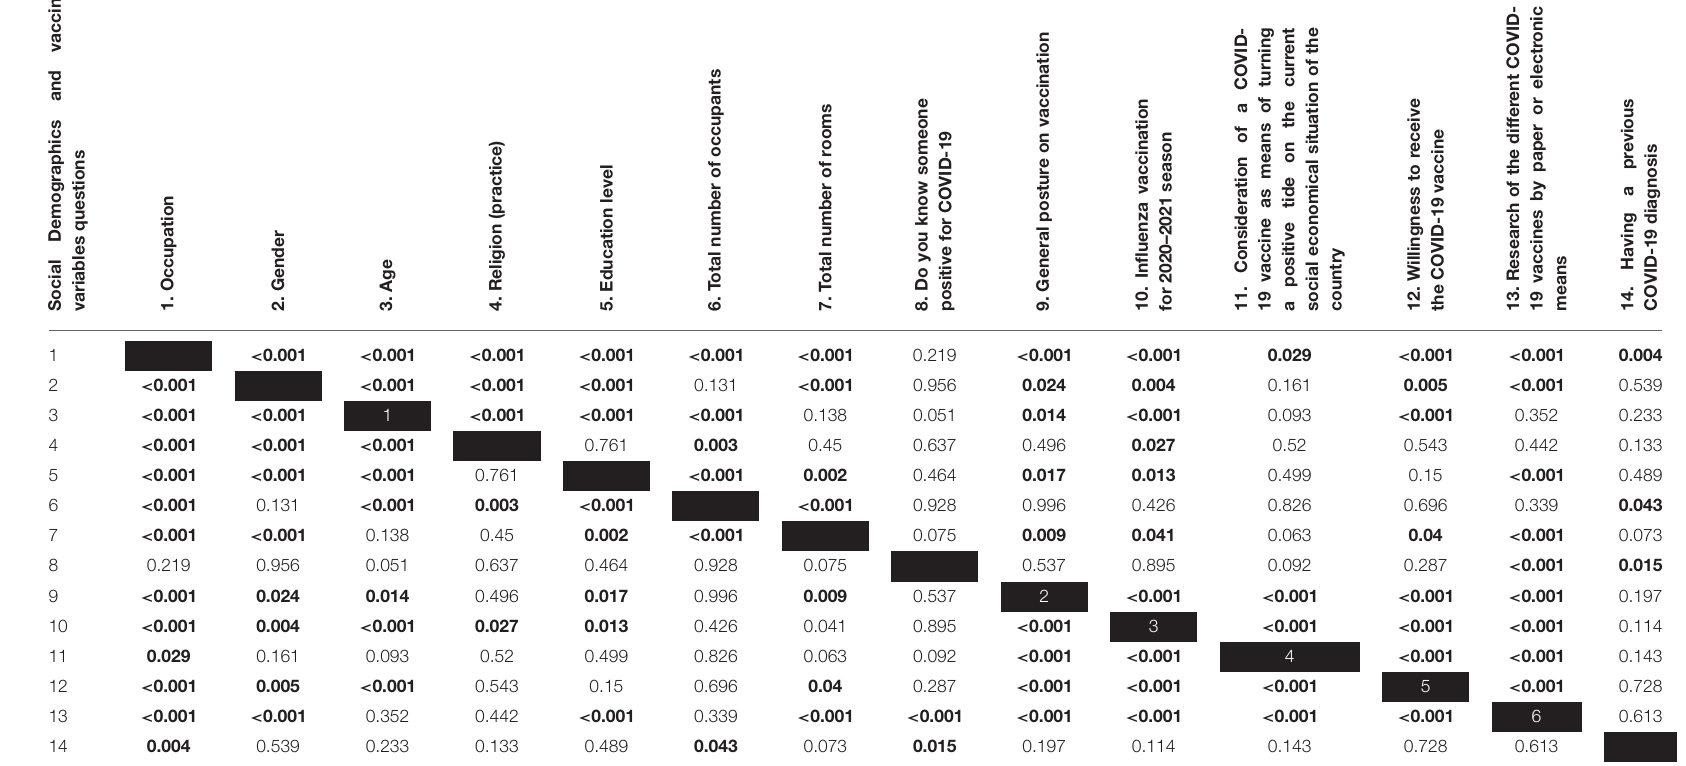
TABLE 4 | Statistical correlation ( p -values) among all the social demographics and COVID-19-related